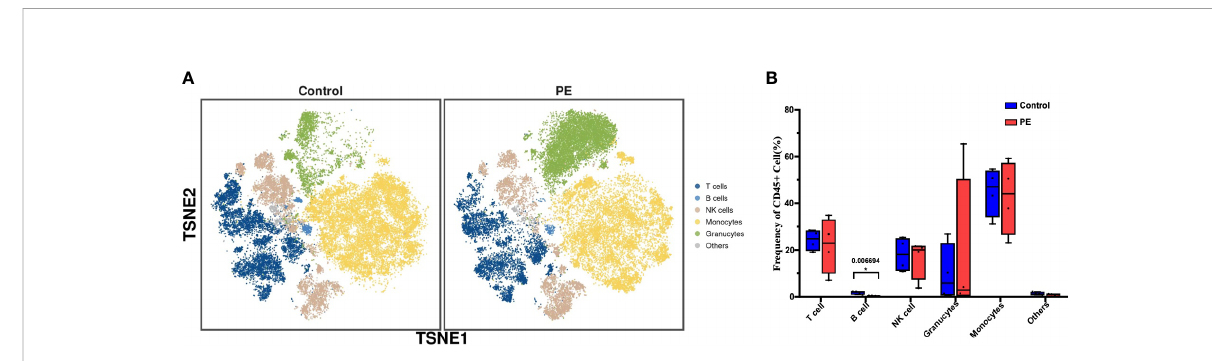
FIGURE 1 The phenotype and functional markers of CD45+ decidual immune cells are altered in PE. (A) t-SNE plot of all CD45+ cells from the PE and control groups that merged into six superclusters, namely, T cells, B cells, natural killer (NK) cells, monocytes, granulocytes, and others. (B) Bar plot of the frequencies of CD45+ cells in all superclusters. The blue bar and red bar denote the control and PE groups, respectively. * stands for p-value <0.01. The number above the asterisk is the exact